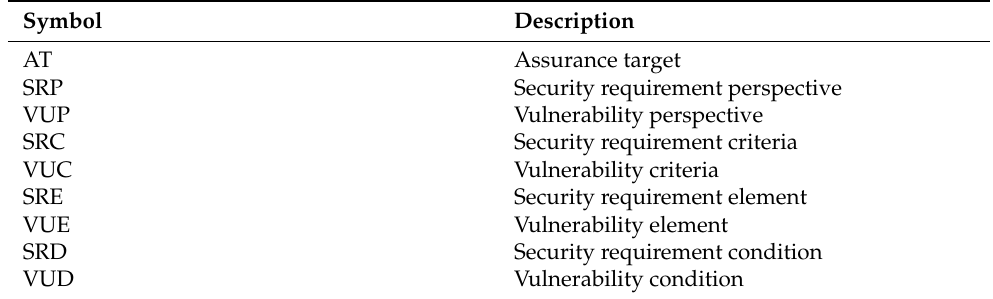
Figure 2. Sample hierarchical structure of the security assurance evaluation. Table 4. Symbols used in the assurance evaluation.